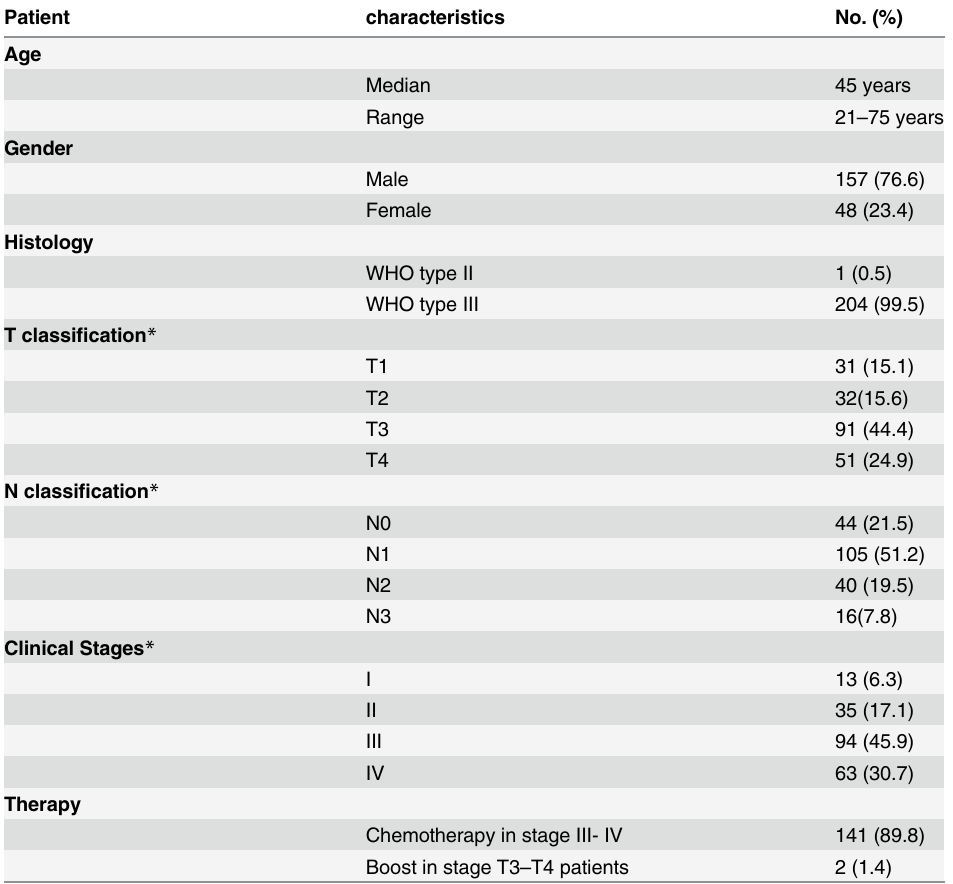
Table 1. Clinical features of the 205 NPC patients in this